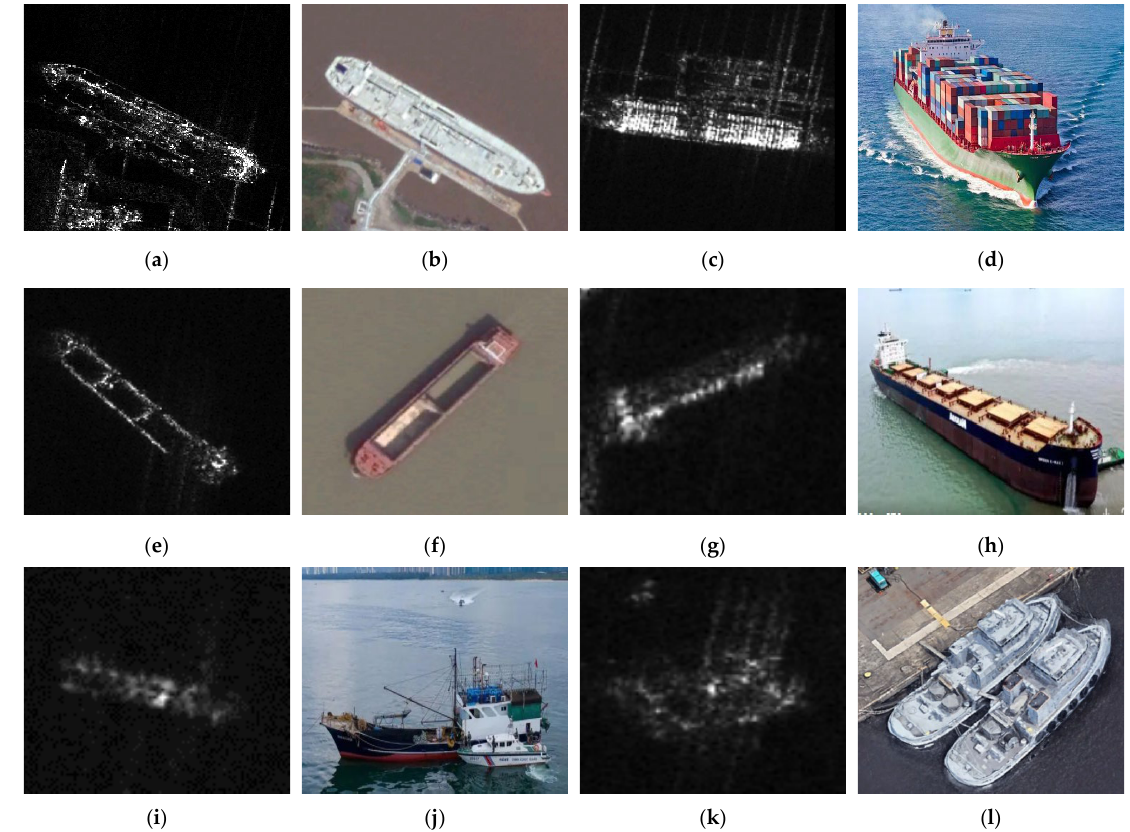
Figure 8. Different types of vessels in the dataset. ( a ) SAR image of an ore-oil ship; ( b ) optical image of an ore-oil ship; ( c ) SAR image of a container ship; ( d ) optical image of a container ship; ( e ) SAR image of a dredger; ( f ) optical image of a dredger; ( g ) SAR image of a bulk cargo ship; ( h ) optical image of a bulk cargo ship; ( i ) SAR image of a fishing boat; ( j ) optical image of a fishing boat; ( k ) SAR image of a law enforcement ship; ( l ) optical image of a law enforcement ship.